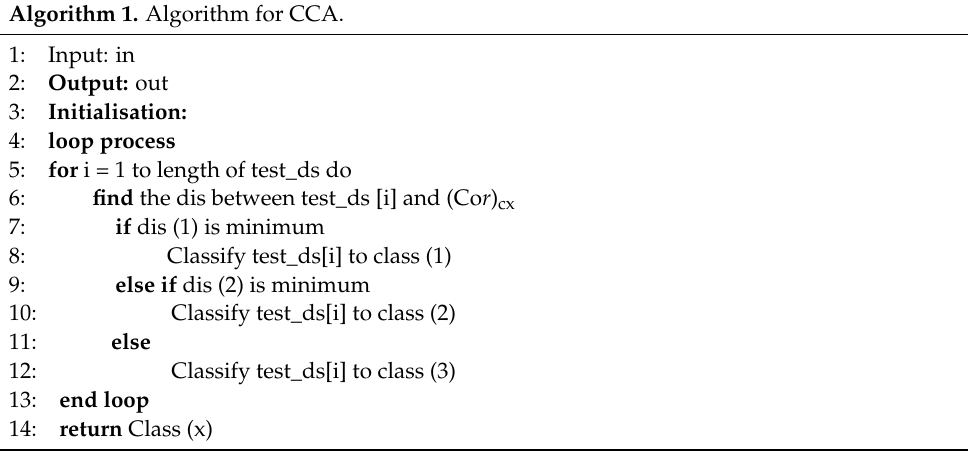
Algorithm 1. Algorithm for